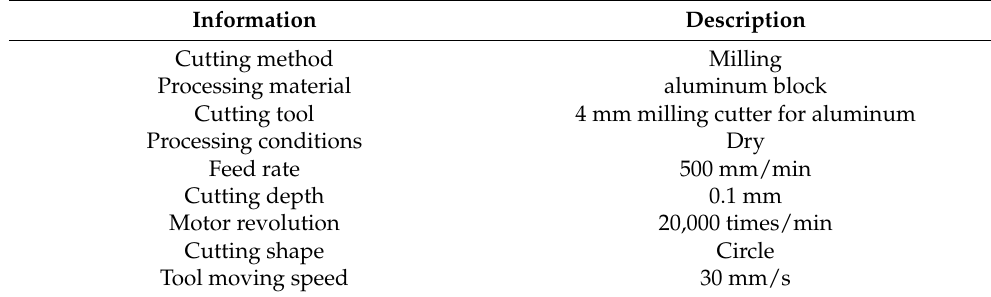
Table 1. Cutting information.